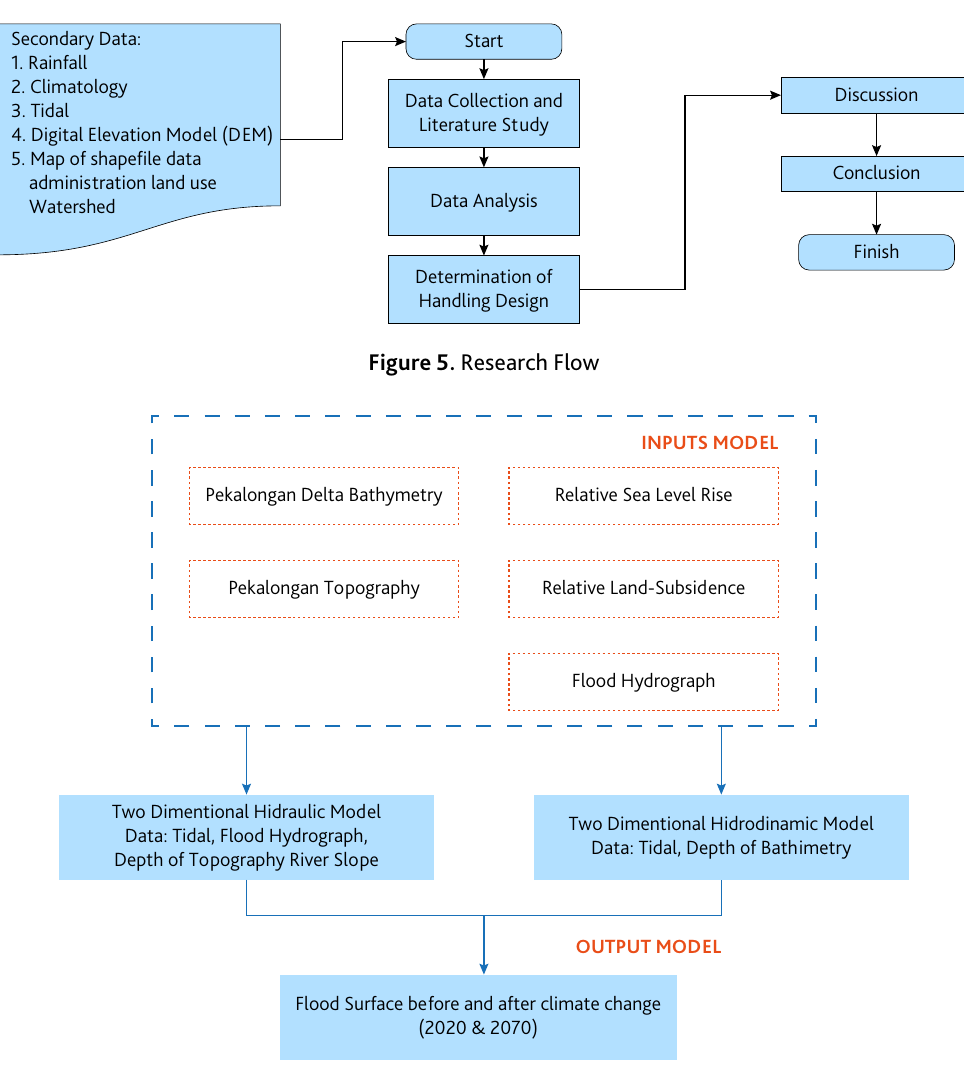
Figure 6. The methodology of two-dimensional hydraulic and hydrodynamic modeling